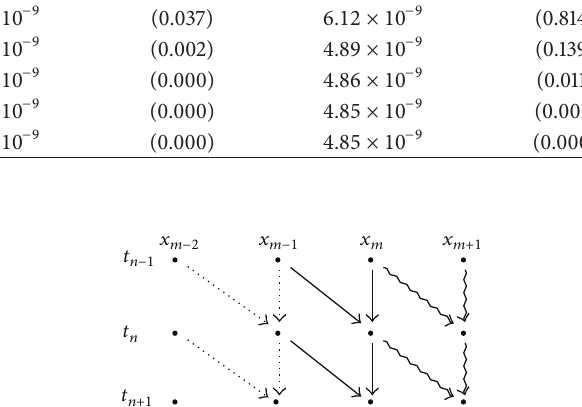
Figure 6: Discretization scheme for the advection problem.